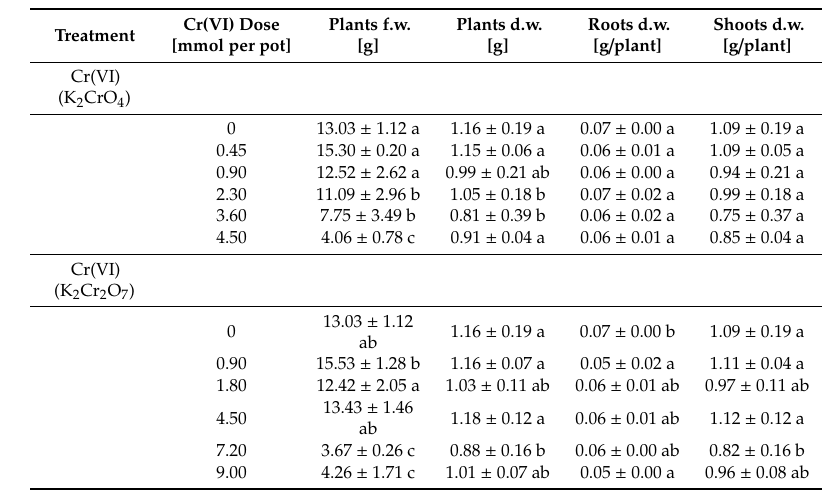
Table 1. Weight of whole plants, roots and shoots determined in a soil pot test upon treatment of the common ice plant, Mesembryanthemum crystallinum with Cr(VI) administered as potassium chromate or potassium dichromate.